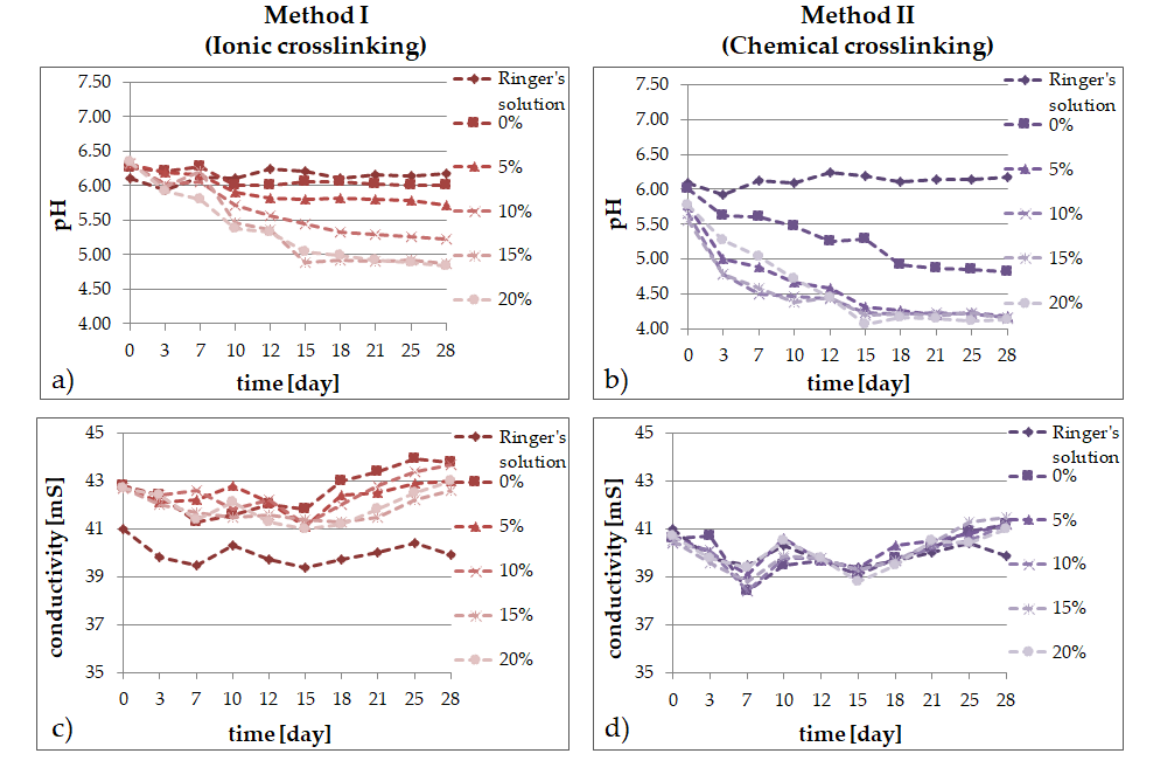
Molecules 2021 , 26 , 2381 Figure 3. Changes of Ringer’s solution during 28 days for SA/PVA/ EP hydrogels prepared using method I (left side) or method II (right side) in pH value ( a , b ) and conductivity ( c , d ).